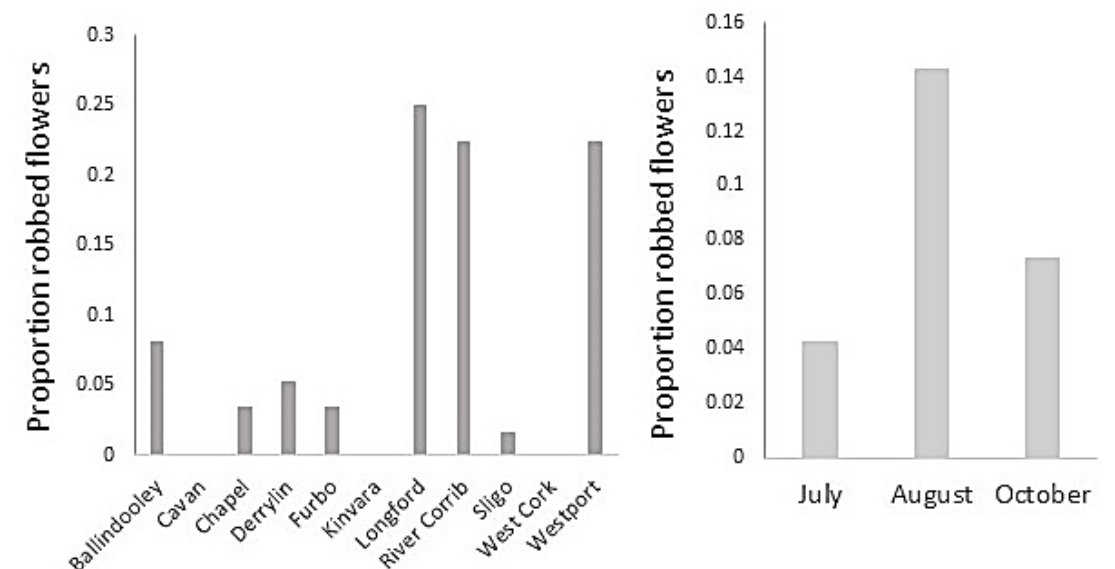
Figure 5. Proportion of all flowers that were robbed varied between (A) sites, and (B) sampling periods.